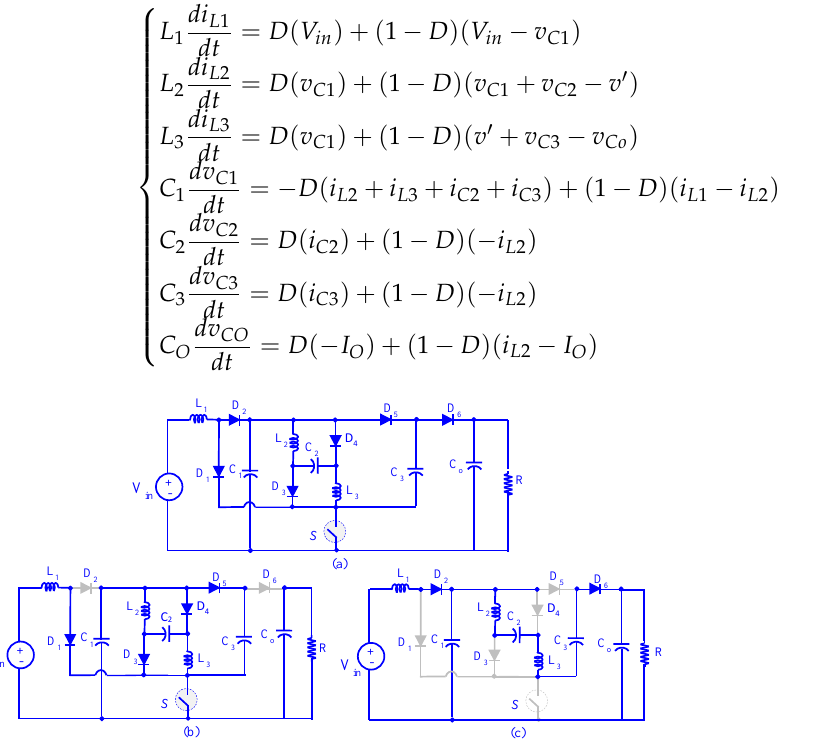
Figure 3. ( a ) The proposed converter, ( b ) the equivalent circuit of the first mode, ( c ) the equivalent circuit of the second